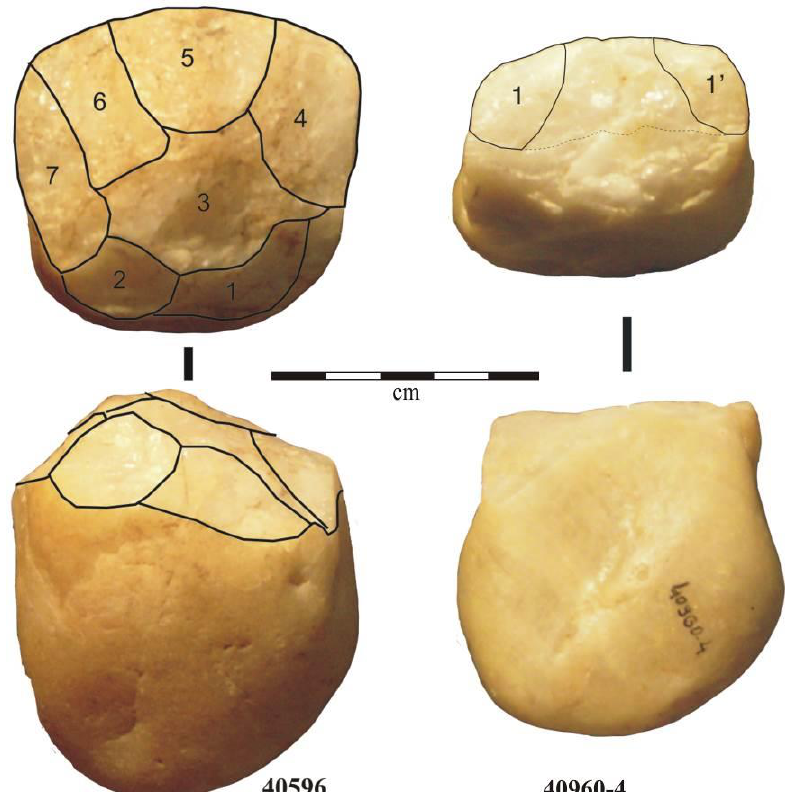
Figure 6. Core tools on quartz pebbles from Pleistocene layer of Sitio do Meio, Pedra Furada 3 phase, older than uncal. 12,640 BP. Numbers refer to FUMDHAM inventory. (Photo by G. Aimola.)